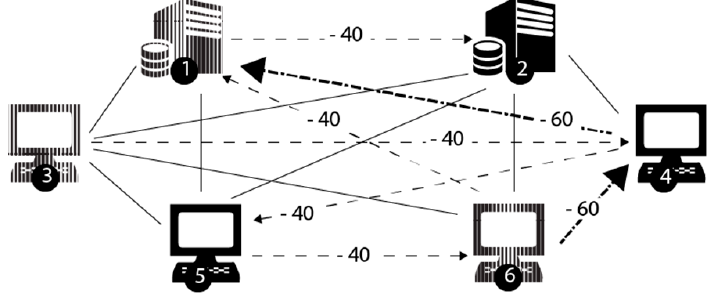
Figure 8. Attack Strategy 2.